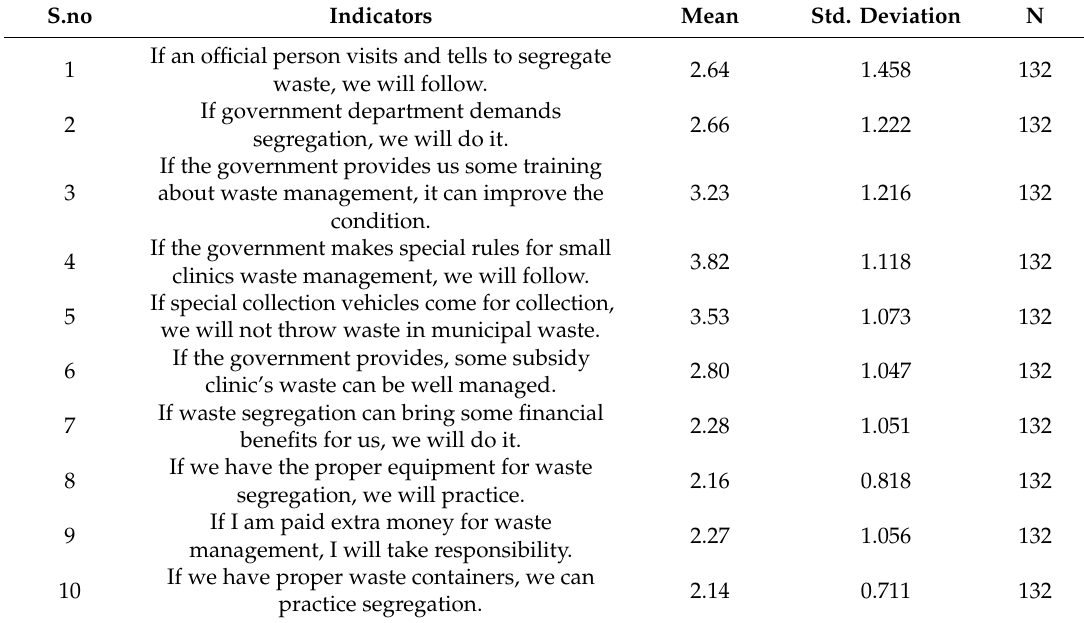
Table 3. Descriptive